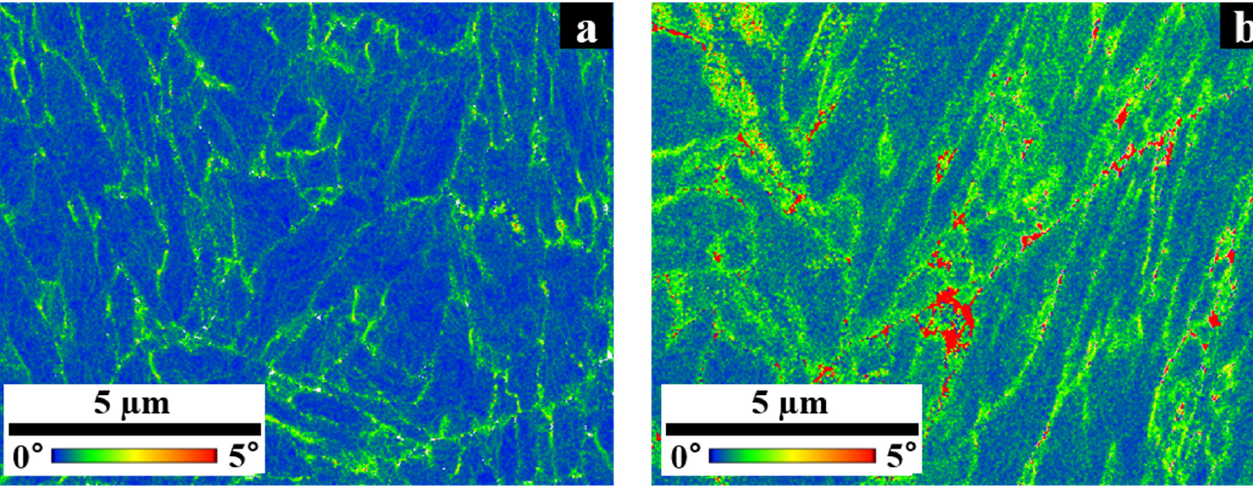
Figure 10. Kernel average misorientation graphs of the 17-4 PH steel heat treated by ( a ) SA and ( b ) NSA.